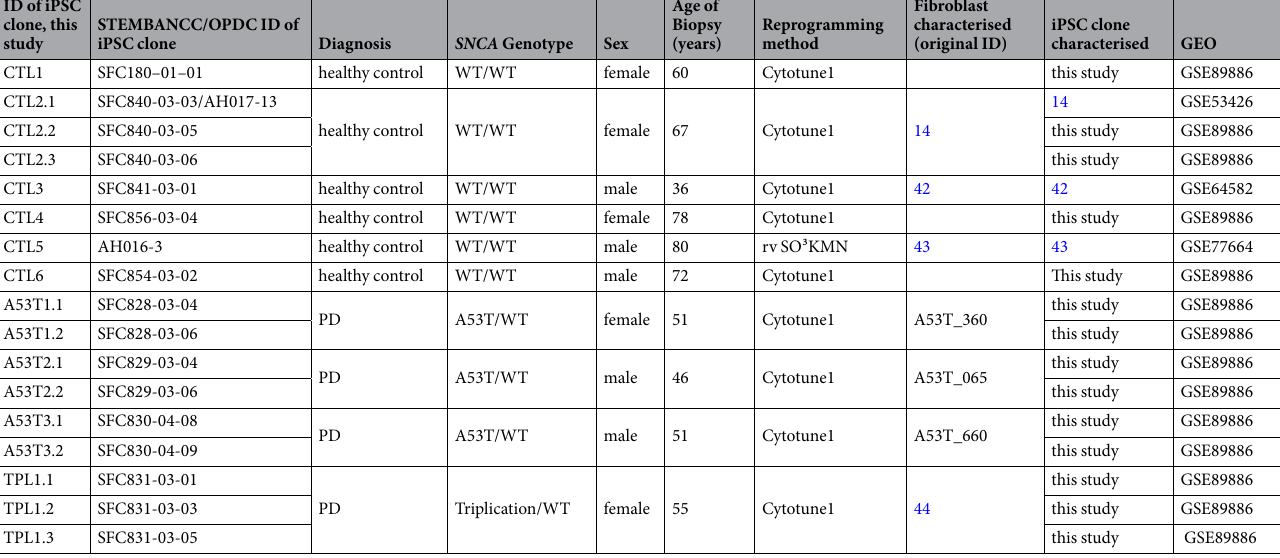
Table 1. iPSC lines used in this